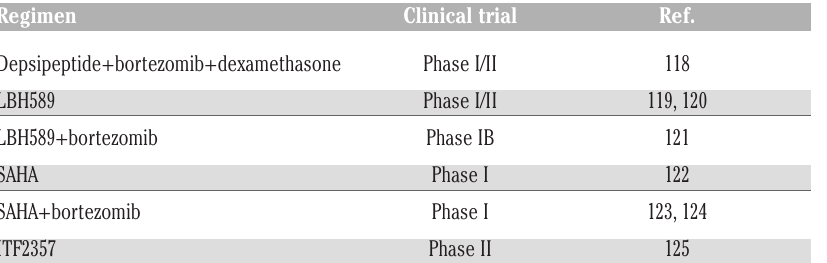
Table 3. Ongoing clinical trials with HDACi as single agent or in combination therapy in MM